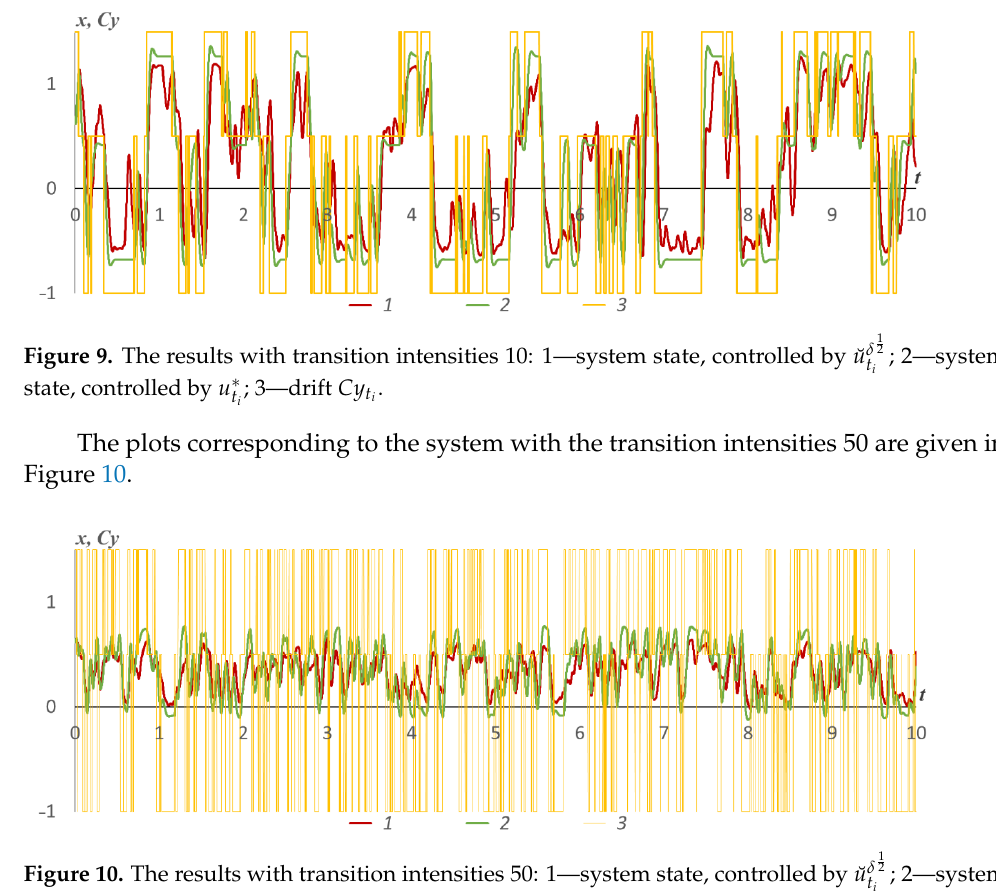
; 3—drift Cy t i i